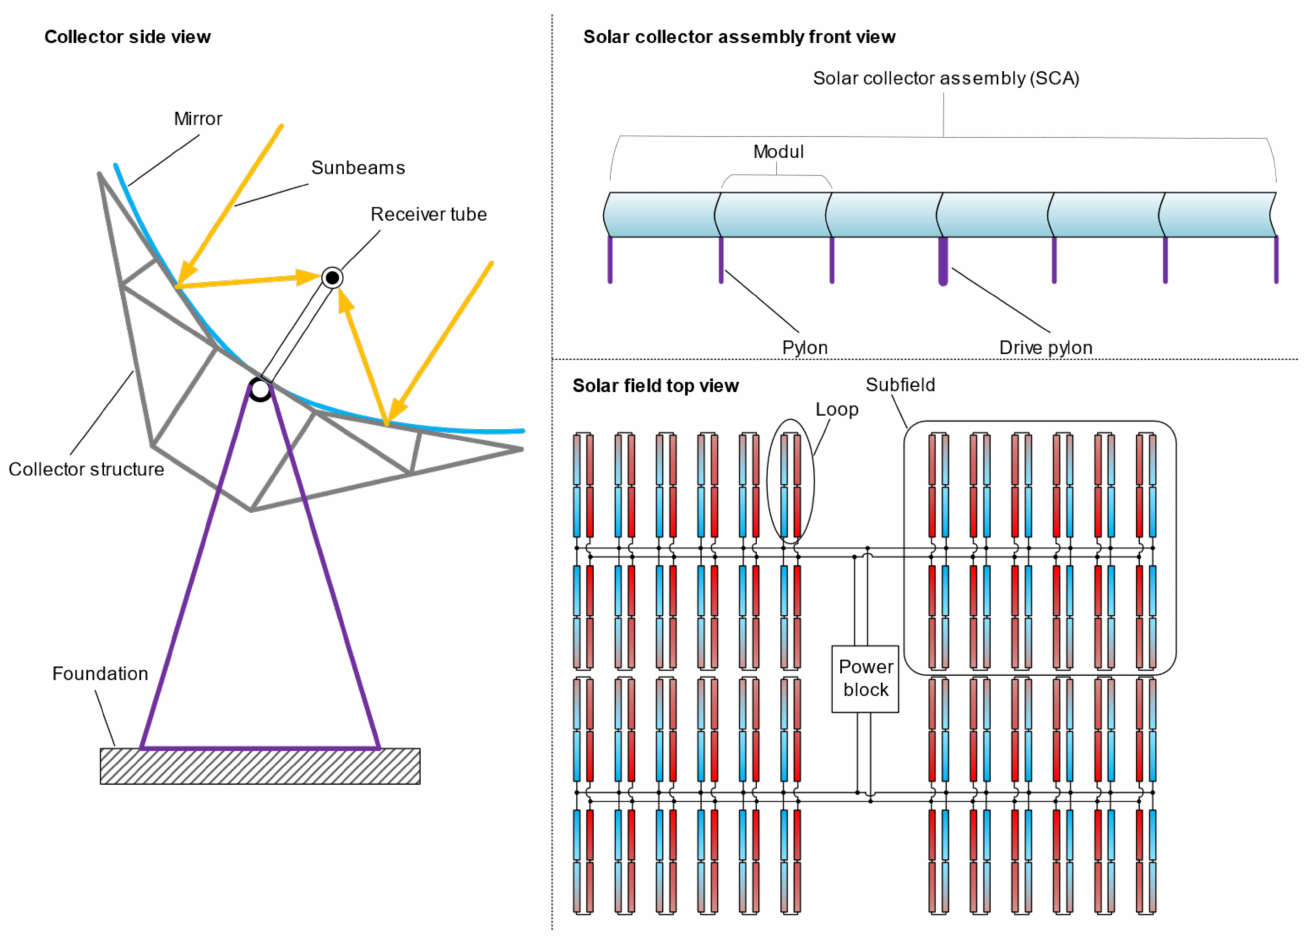
Figure 1. Parabolic trough overview, single collector structure in side view ( left ), solar collector assembly in front view ( top right ), whole solar field with typical H-layout in top view ( bottom right